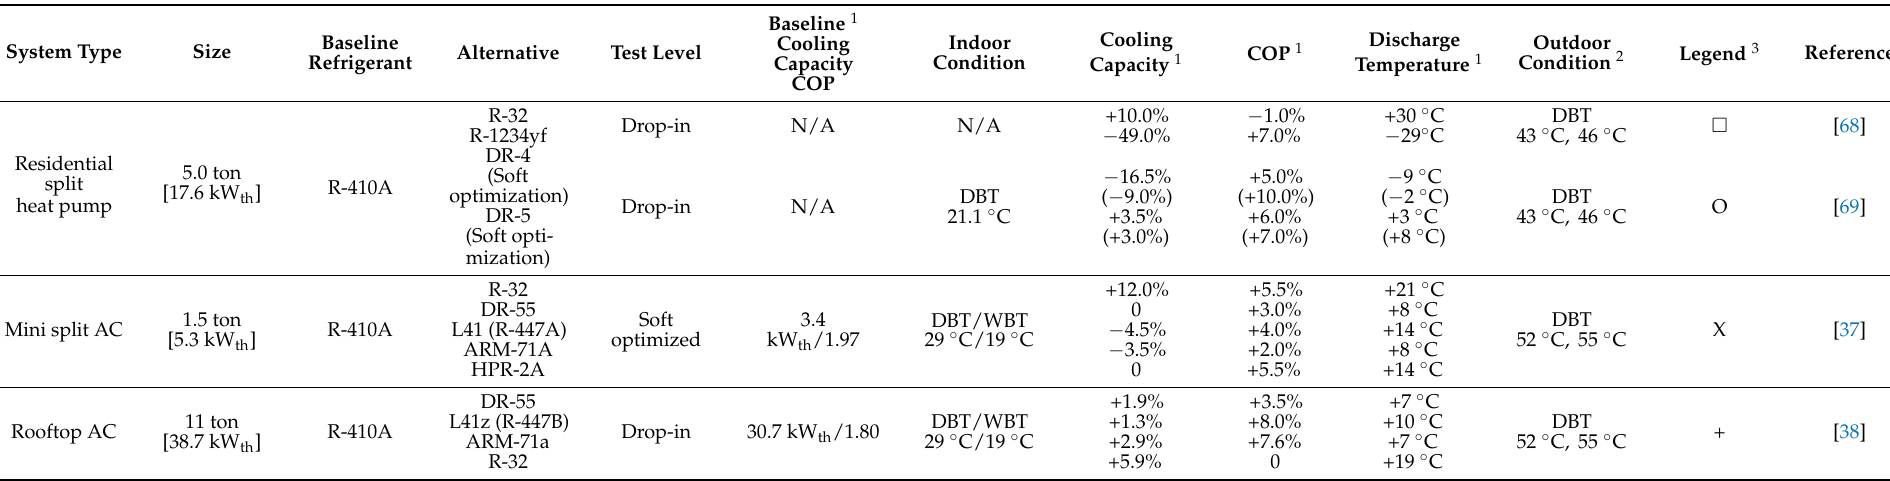
Table 10. Experimental results (except for AHRI Low-GWP AREP) for R-410A alternative refrigerants at HAT